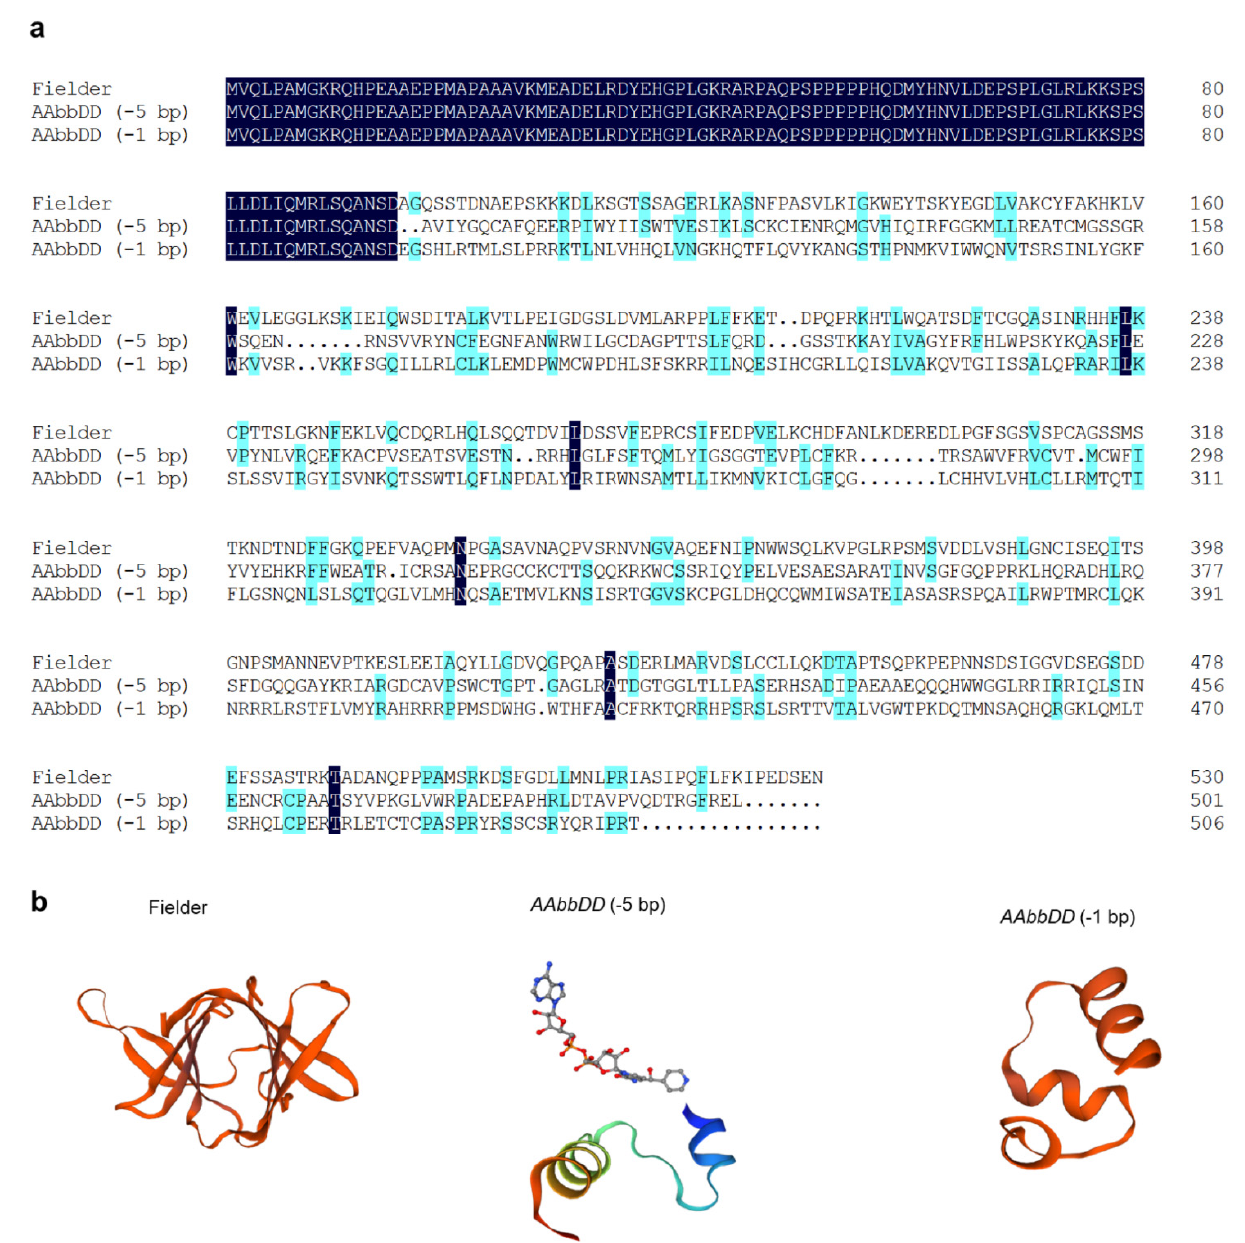
Figure 2. Amino acid sequences and prediction of the three-dimensional structures of the TaDHL-7B protein for ‘Fielder’ and the mutant genotypes AAbbDD ( − 5 bp) and AAbbDD ( − 1 bp). ( a ) Amino acid sequences; ( b ) three-dimensional structures of the protein .